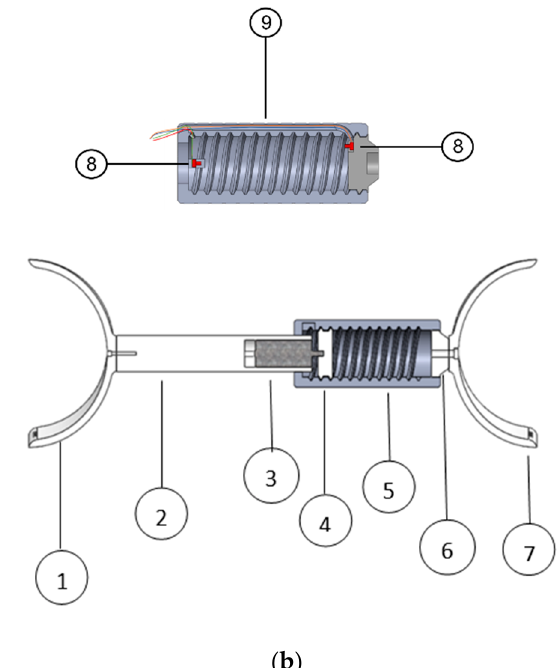
Figure 4. 3D model of the motorised device: ( a ) Global visualization; ( b ) Detail with components, (1)—motor grip, (2)—movable side element, (3)—DC motor, (4)—threaded element, (5) central element, (6)—fastening element, (7)— fixed grip, (8)—positioning of end limit switches, (9)—embedded wire for signal transport.